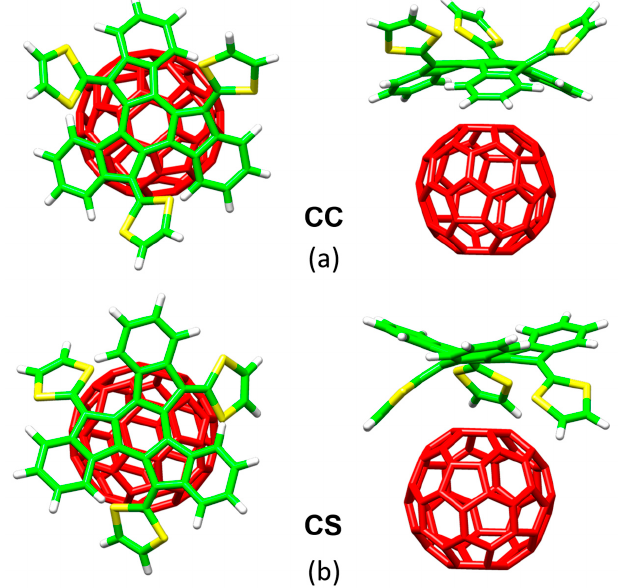
Figure 8. Minimum-energy structures of the truxTTF•C 60 complex calculated at the MPWB1K/6-31G** level. Top and side view of structures CC ( a ) and CS ( b ) are given. The electron-acceptor C 60 is colored in red whereas the sulfur, carbon and hydrogen atoms in the electron-donor system are colored in yellow, green and white,